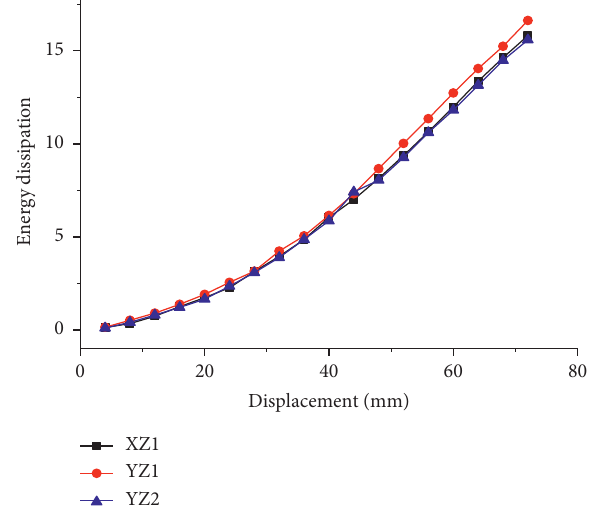
Figure 15: Energy consumption-displacement curves.